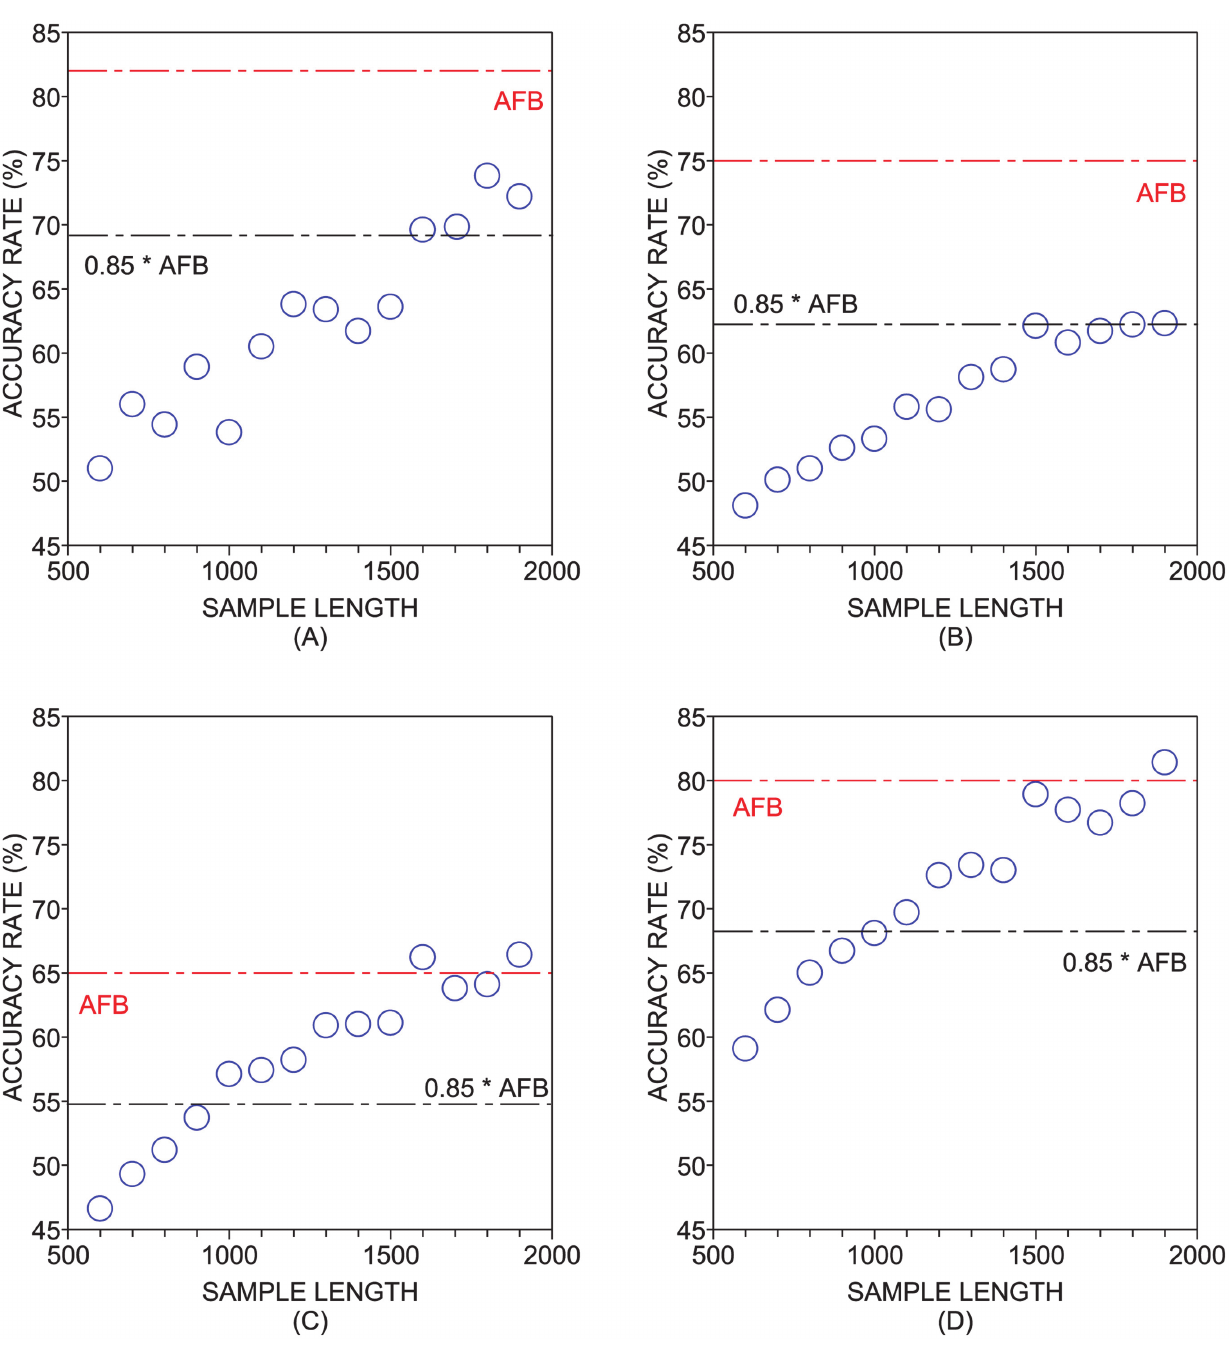
Fig 4. Accuracy rate as a function of the subtext length. The classifiers employed were (a) kNN; (b) Naive Bayes; (c) C4.5; and (d) SVM. The accuracy rate obtained with full texts (AFB) is represented as a red dashed line. Considering all the classifiers employed in the experiments, one can obtain 85% of the discriminability found with full books ( W = 21,400) if one analyzes subtexts comprising at least W = 1,700 tokens.